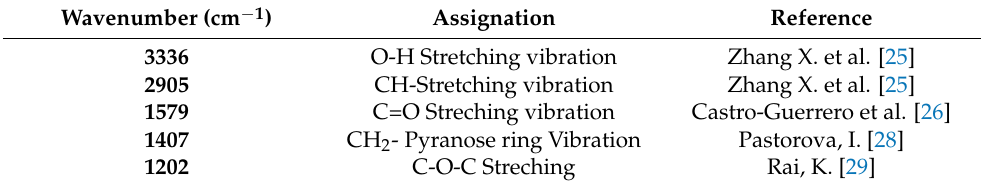
Table 1. Functional